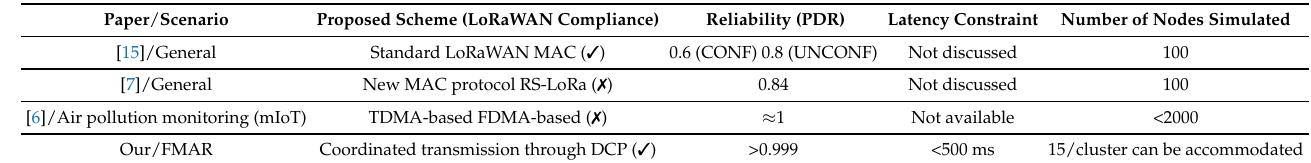
Table 7. Performance comparison with other works from the